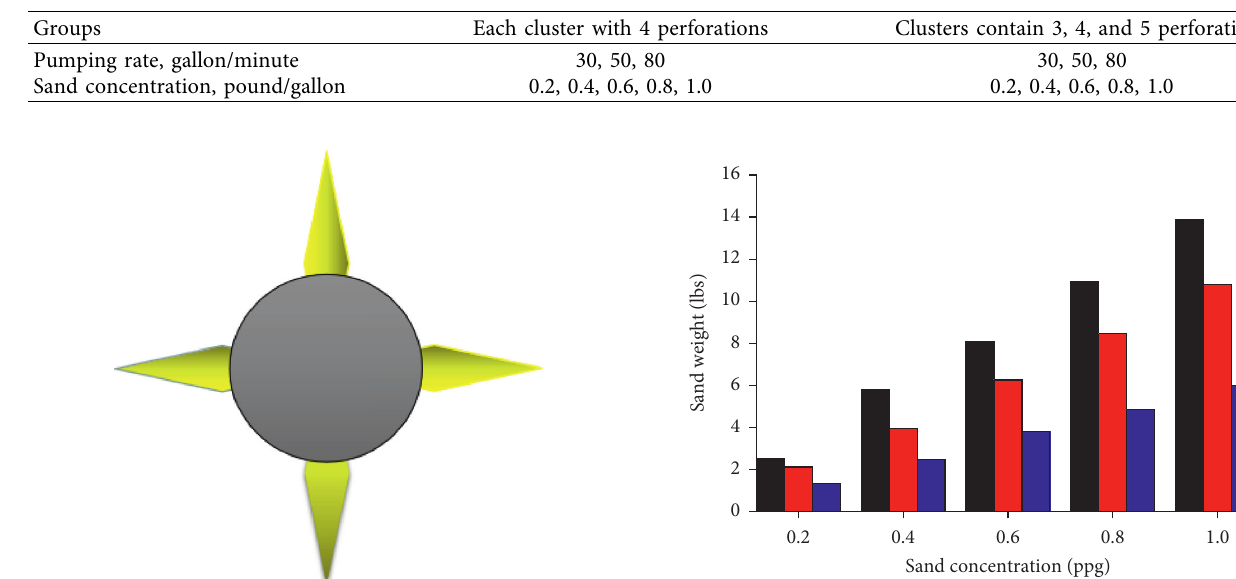
Figure 1: Experimental equipment and work flow (Faraj and Miskimins, 2011). Table 1: Experimental groups and parameters.